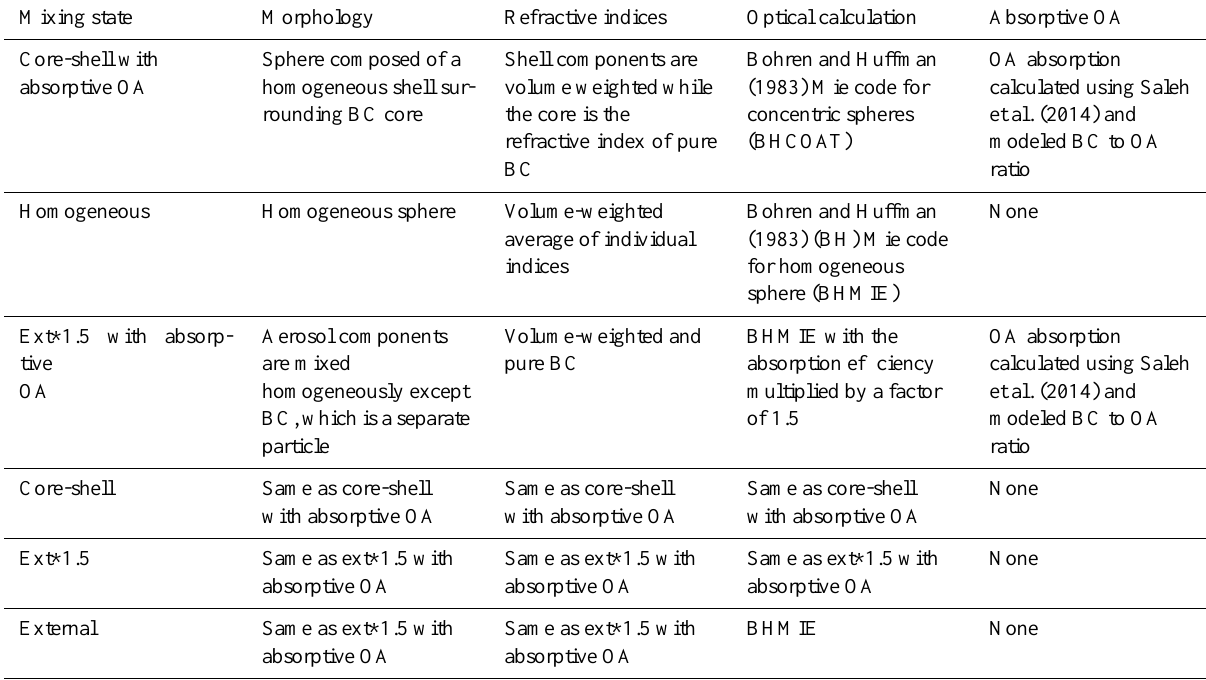
Table 1. Description of mixing-state assumptions. Mixing state Morphology Refractive indices Optical calculation Absorptive OA